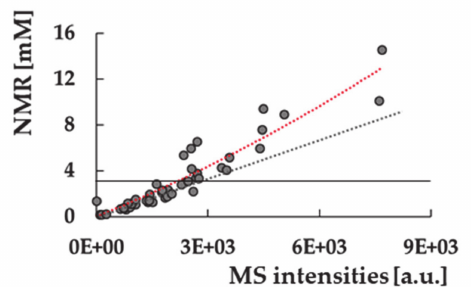
Figure 3. Correlation between MS intensity distribution and NMR concentrations for hippuric acid. MS signals are saturated for concentrations over 3.8 mM (continuous black line). Deviation from linearity (dashed black line) is significant (dashed red line). For these samples, only values measured by NMR were considered.